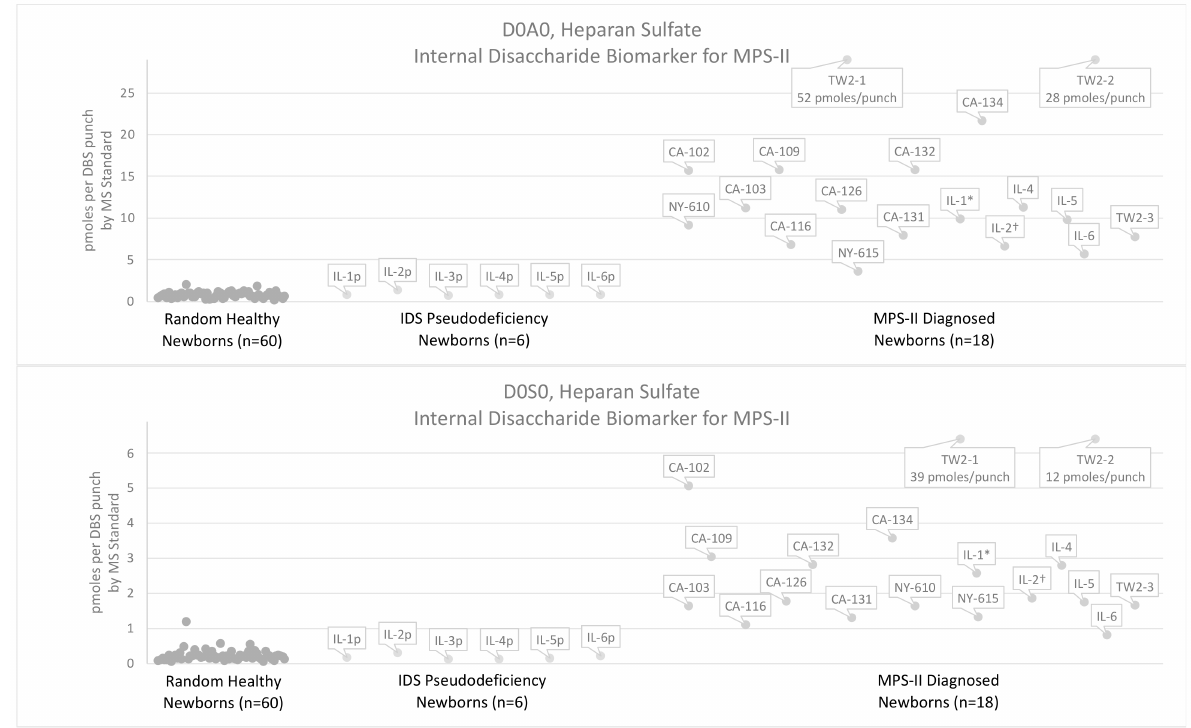
Figure 3. Levels of heparan-sulfate-derived (D0A0, D0S0) internal disaccharides measured in DBS from 60 random healthy newborns, 6 newborns with IDS pseudodeficiency, and 18 newborns diag- nosed with MPS-II. Biomarkers measured using the internal disaccharide method with heparinase digestion in buffer. Note that one random healthy newborn DBS showed high D0S0 levels compared to the healthy newborn pool. TW2-1 and TW2-2 showed very high D0A0 and D0S0 levels above the range of the plots (52 pmoles D0A0/punch and 28 pmoles D0A0/punch, and 39 pmoles D0S0/punch and 12 pmoles D0S0/punch). The D0A0 and D0S0 levels for these two samples are labeled in the plots. * DBS from patient with undetermined phenotype, † DBS from patient with attenuated pheno- type, “p” DBS from newborn that failed tier-1 IDS screening, pseudodeficiency identified, no MPS-II diagnosis, Label key and DBS storage conditions: CA = California (frozen), IL = Illinois (frozen), TW = Taiwan (frozen), NY = New York